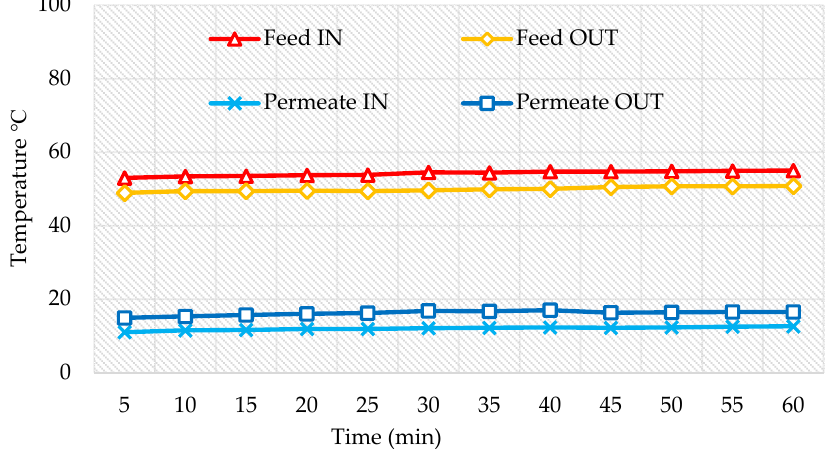
Figure 8. Feed and permeate temperature in case of the empty channel by using 3 L/min.